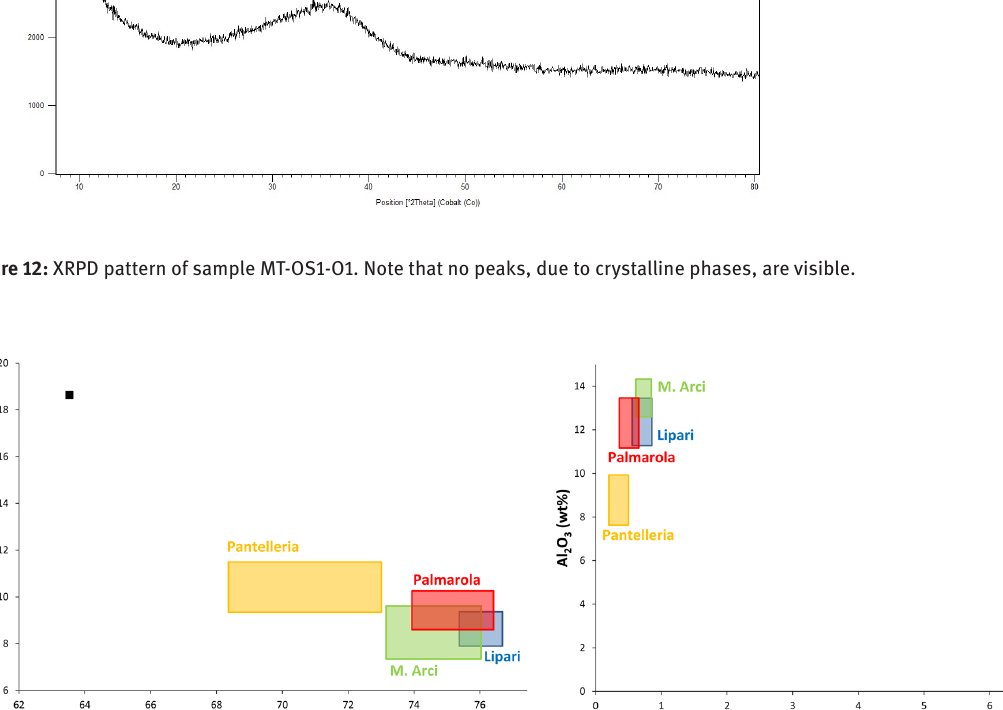
O (c) plots, in which sample MT-OS1-O1 (■) is compared with literature 2 3